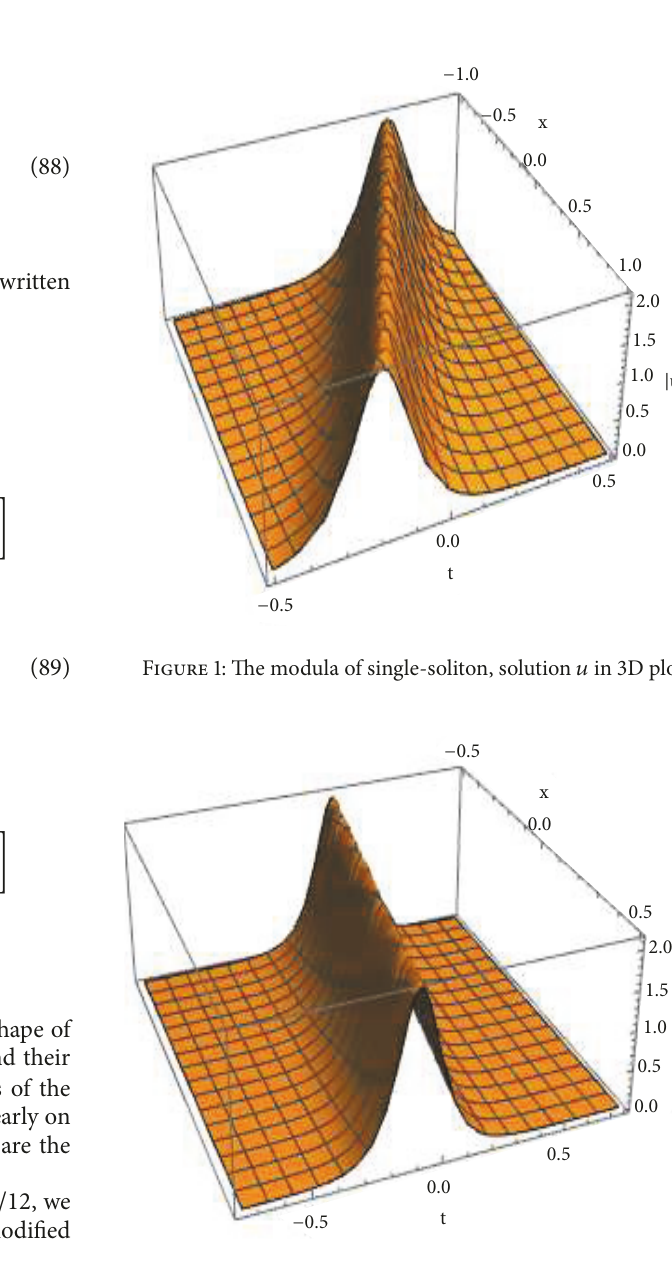
Figure 2: The modula of single-soliton, solution V in 3D